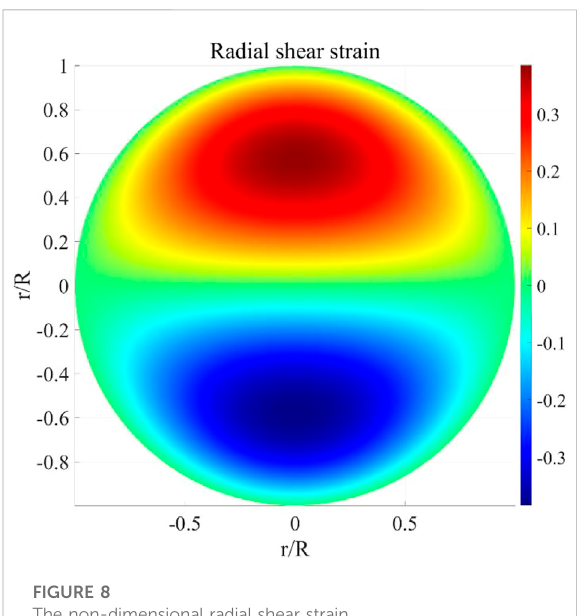
FIGURE 8 The non-dimensional radial shear